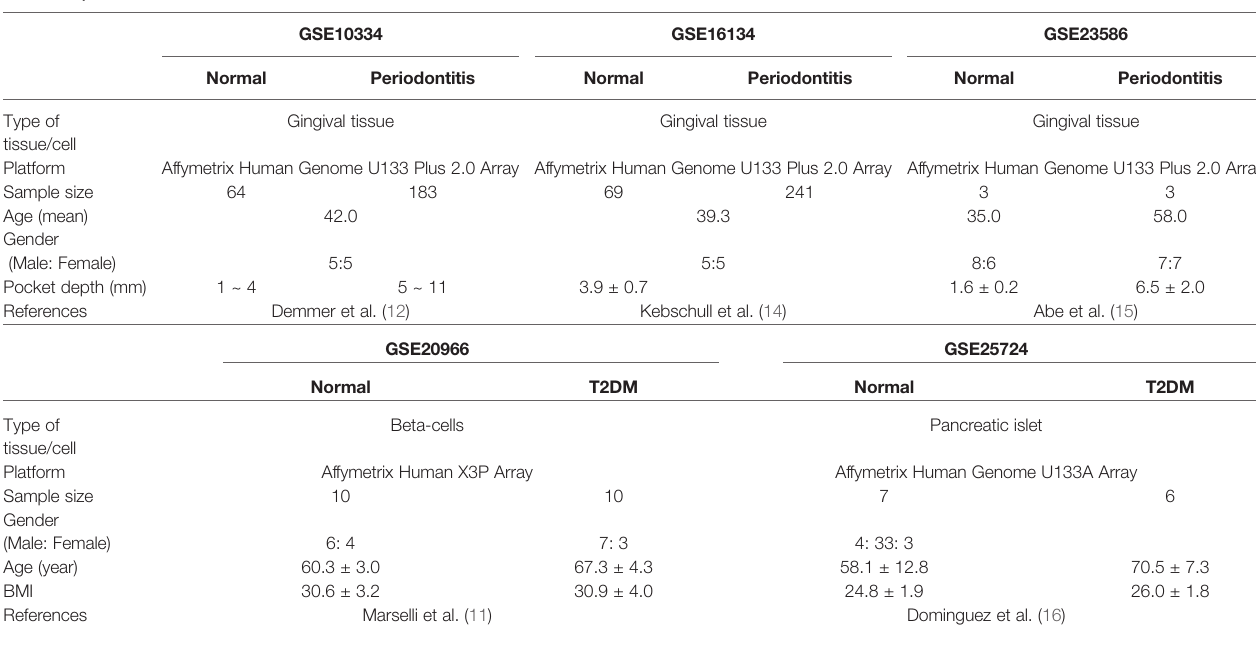
TABLE 2 | Characteristics of included datasets.